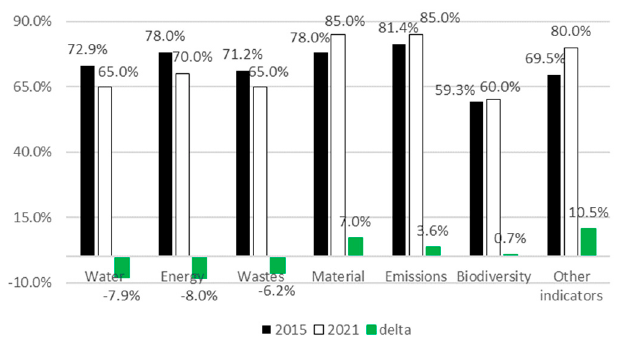
Figure 3. Organisations that monitor core indicators. Source: Reprinted from [19].